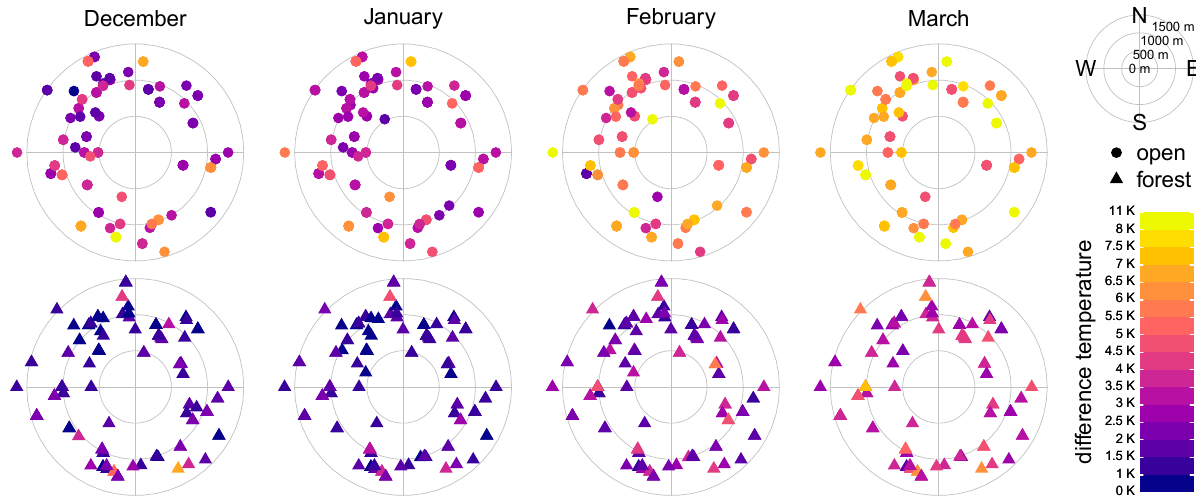
Figure 5. Average air temperature differences between 12 ( top ) and 4 o’clock ( bottom ) for consecutive months in the winter season. The orientation shows the exposure, the distance to the center denotes the elevation, and the color reflects the mean air temperature differences.